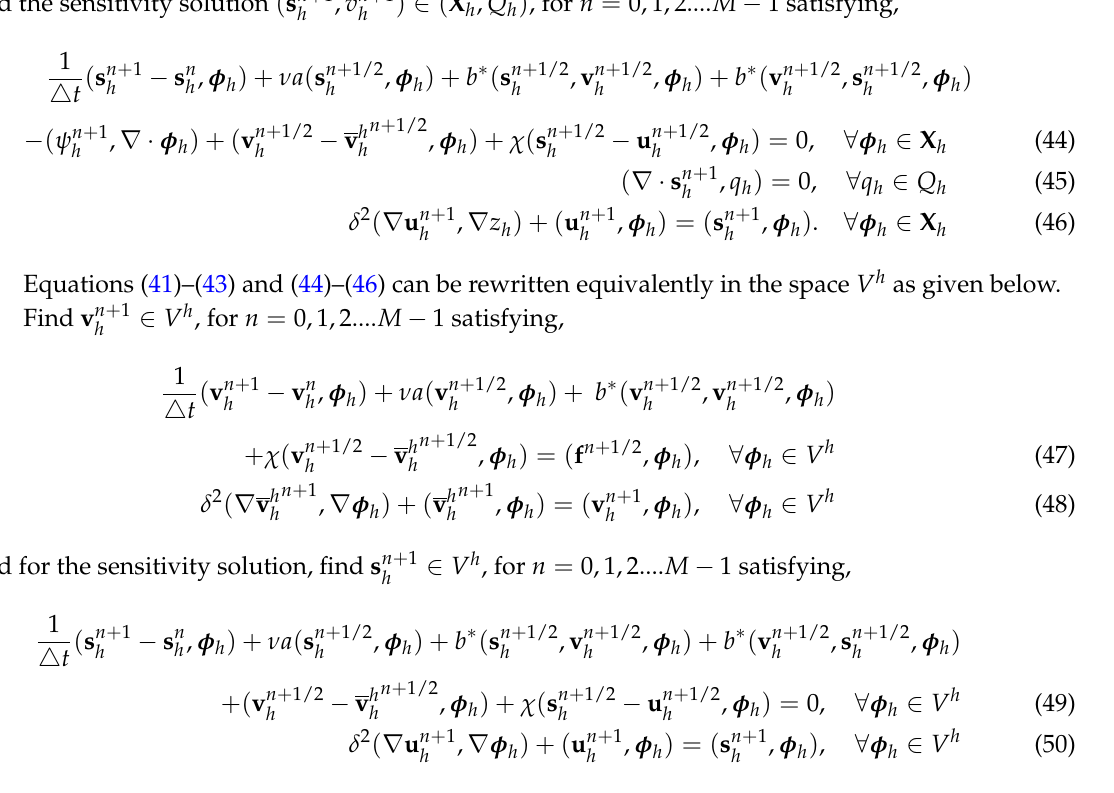
Table 3. Computations of χ || s SEM ||